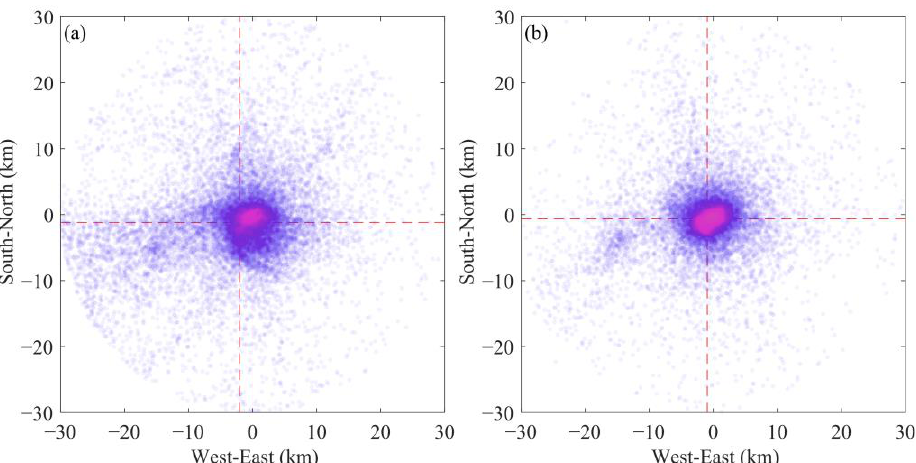
Figure 10 . Location offsets of all matched events. Each matched ADTD event is taken to be at (0,0), and the corresponding event ’ s location is plotted relative to this point. The dotted lines indicate the average offsets. ( a ) For the uncorrected events, the average westwards offset is 2.05 km, and the average southwards offset is 1.19 km. ( b ) For the corrected events, the average westwards offset is 0.93 km, and the average southwards offset is 0.63 km.